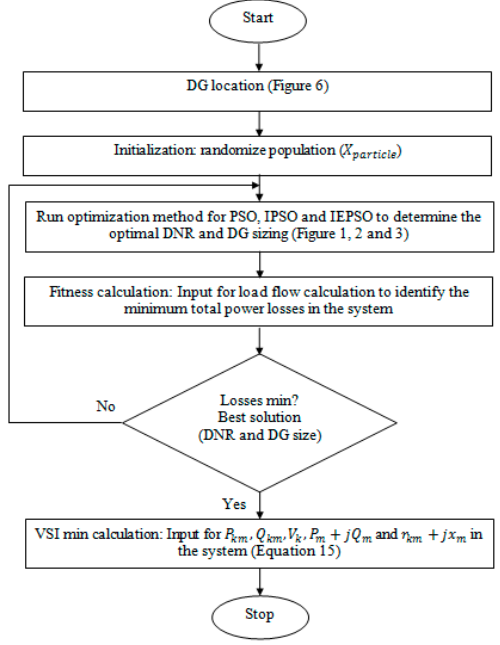
Figure 4. Overall process for distribution network reconfiguration (DNR) and DG sizing.